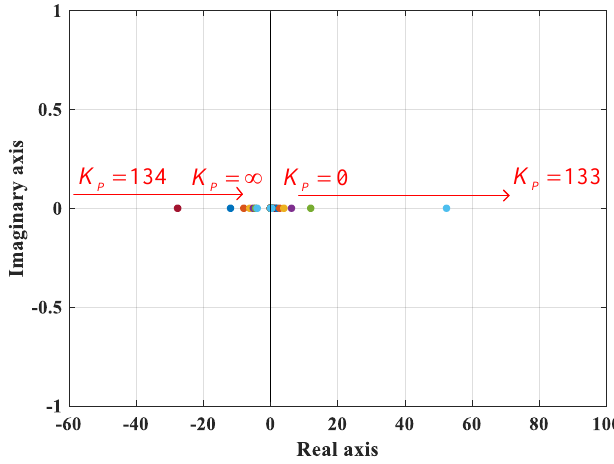
Figure 6. Eigenvalues of the P matrix for positive values of K P and K i =